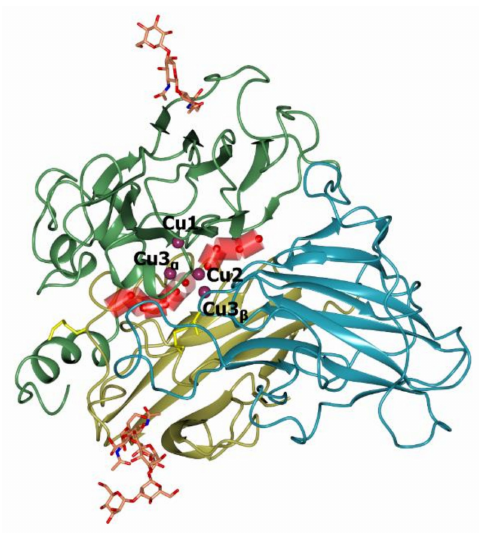
Figure 3. The overall structure of Coriolopsis caperata laccase (PDB 3JHV, [60]). The first domain is shown in gold, the second in green, and the third in blue color. Copper atoms are shown with purple spheres. Sugars are shown with stick models, atoms are colored by type (C—orange, O—red, N—blue). Disulfide bridges are shown in